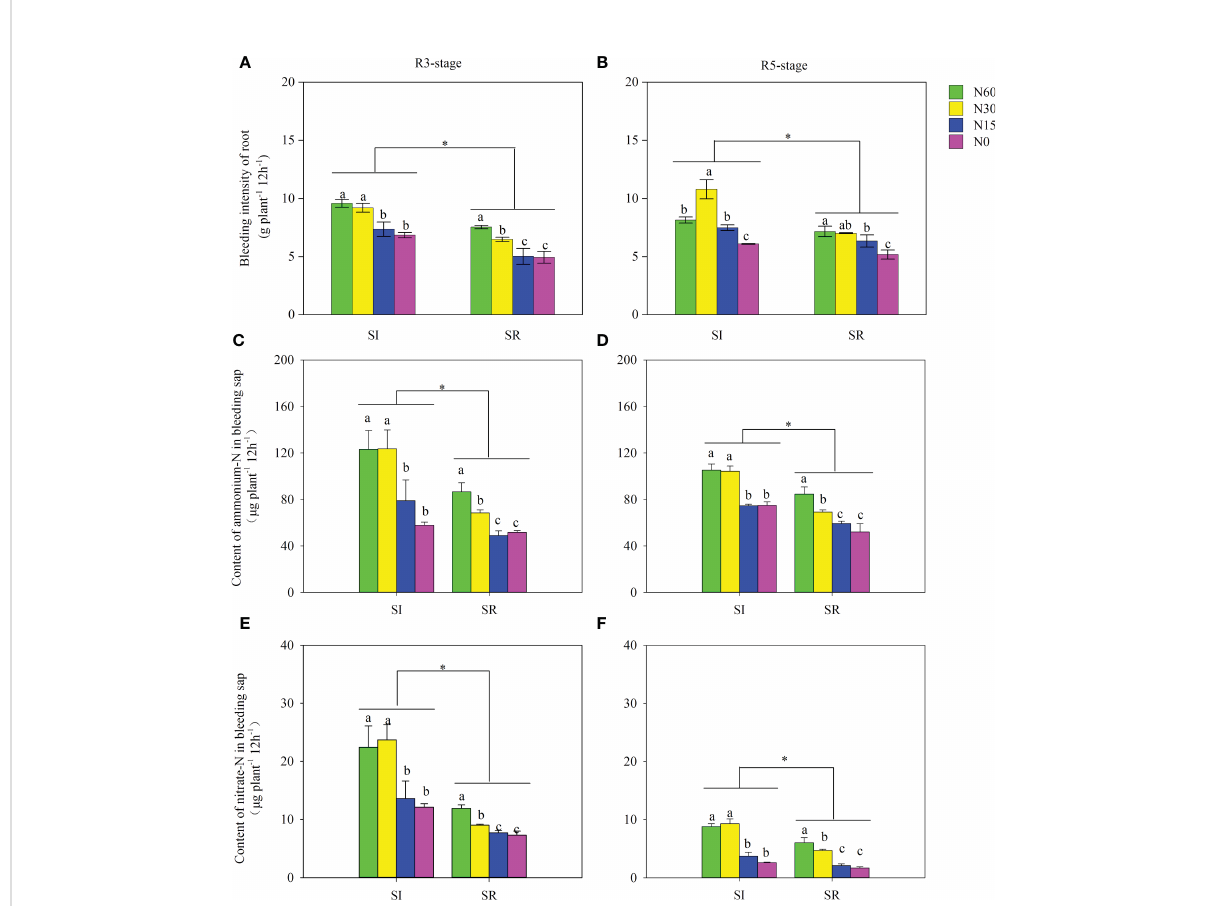
FIGURE 3 Effects of straw incorporation and nitrogen application on root bleeding intensity and N content at different growth stages. Different lower-case letters indicate signi fi cant differences under different N application rates ( LSD , P < 0.05). Data were shown as mean±S.D. (n=3). The asterisk "*" indicate signi fi cant differences ( P < 0.05) between straw incorporation and straw removal, respectively. SI, straw incorporation; SR, straw removal; N60, convention N (60 kg N ha-1); N30, reduced N by 50% (30 kg N ha-1); N15, reduced N by 75% (15 kg N ha-1); N0, zero N (0 kg N ha-1); V5, the fi fth trifoliolate stage of soybean; R3, the beginning pod stage of soybean; R5, the beginning seed stage of soybean. (A) , bleeding intensity of soybean root at the R3 stage; (B) , bleeding intensity of soybean root at the R5 stage; (C) , content of ammonium-N in bleeding sap at the R3 stage; (D) , content of ammonium-N in bleeding sap at the R5 stage; (E) , content of nitrate-N in bleeding sap at the R3 stage; (F) , content of nitrate -N in bleeding sap at the R5